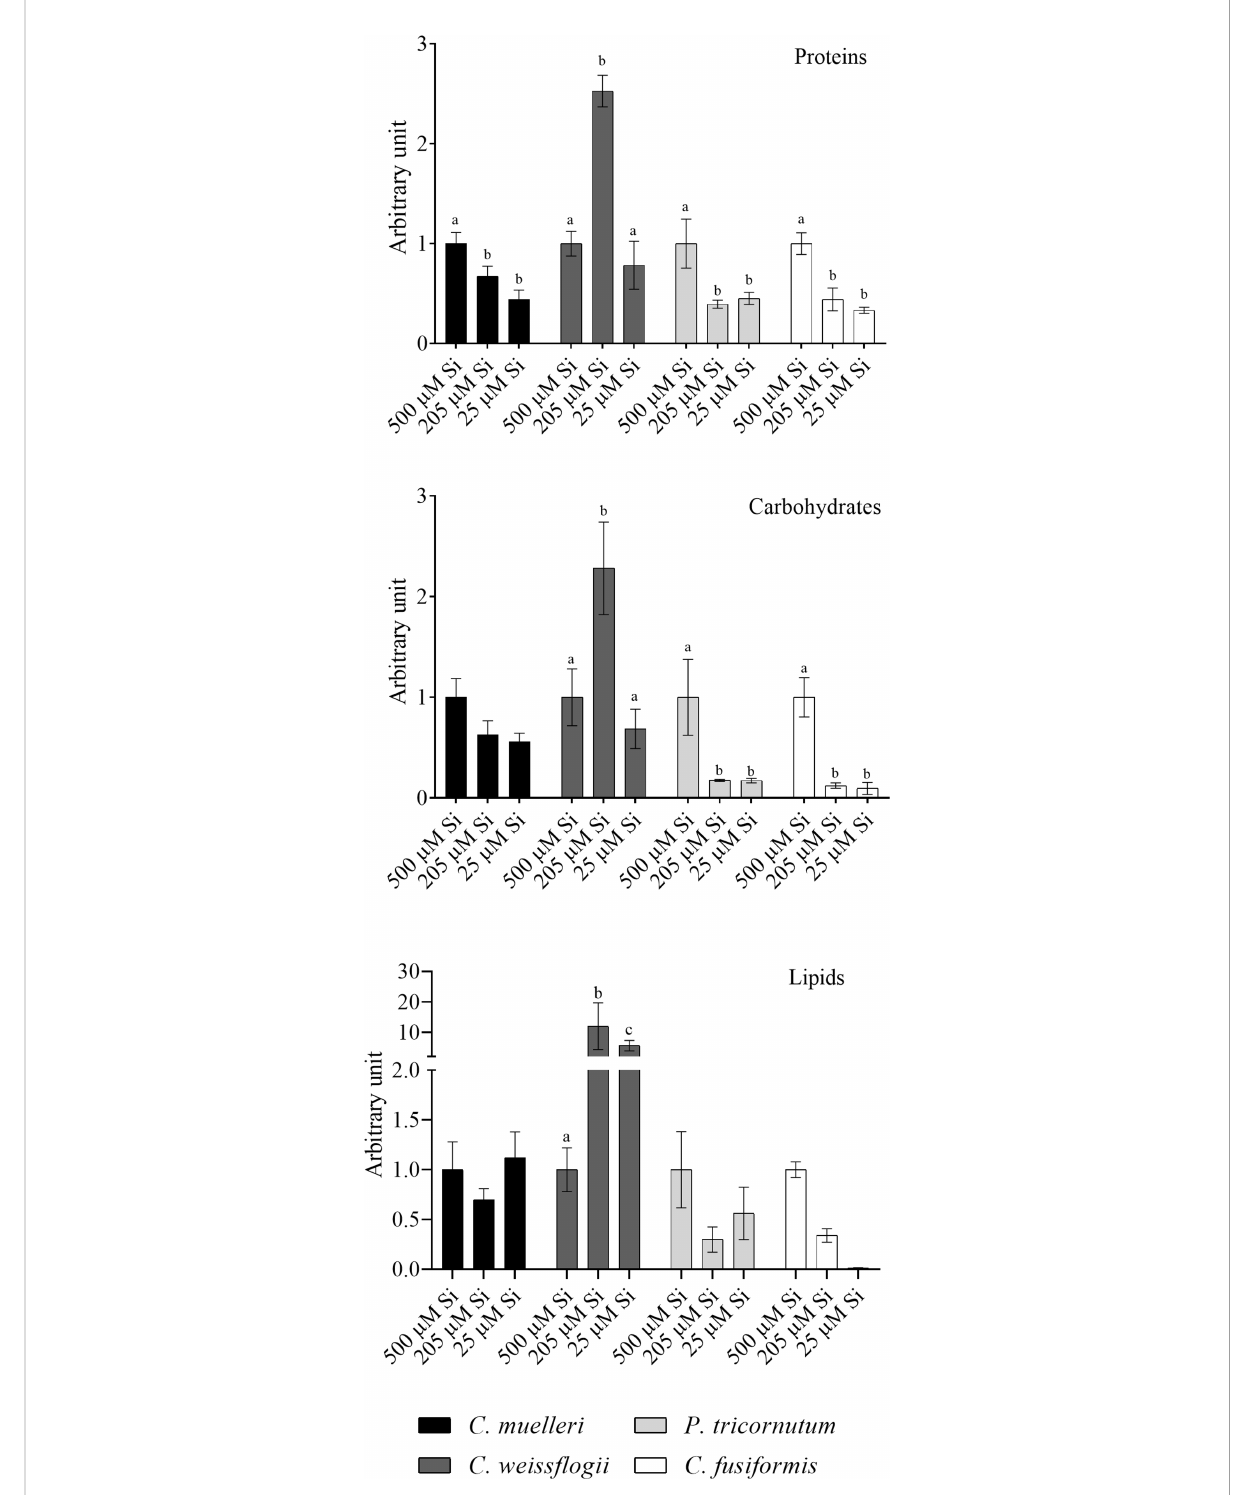
FIGURE 3 Protein, carbohydrates, and lipid pools in the four diatoms acclimated to different paleoenvironments. Data are means of three replicates. Error bars show SD. Different letters represent signi fi cant differences among conditions in the same species (p < 0.05, two-way ANOVA followed by Tukey ’ s post-hoc test, results in Table S3